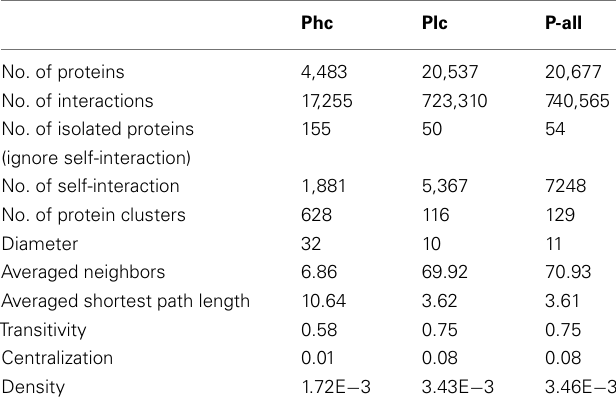
Table 2 | Structural properties depicting the interactome P-all and two confidence levels of the sub-network: high confidence (Phc) and low confidence